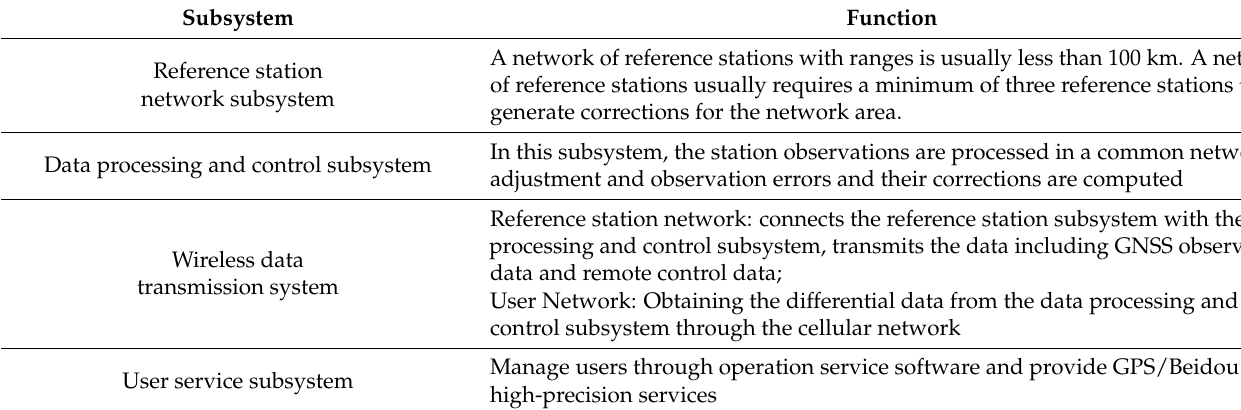
Table 2. RTK network elements based on cellular networks.